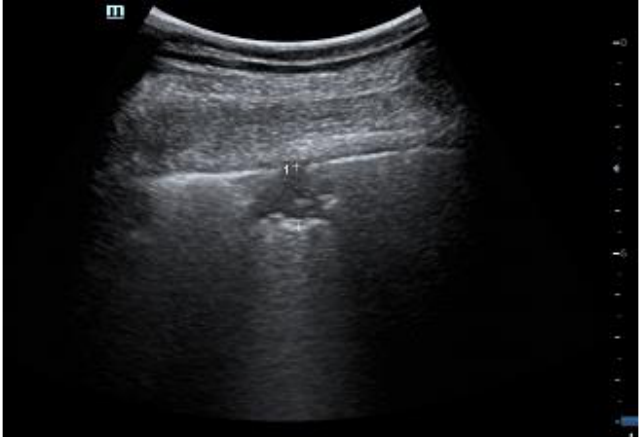
Figure 5. Patient with COVID-19 lung involvement. A small consolidation under the pleura, sur- rounded by white lung.